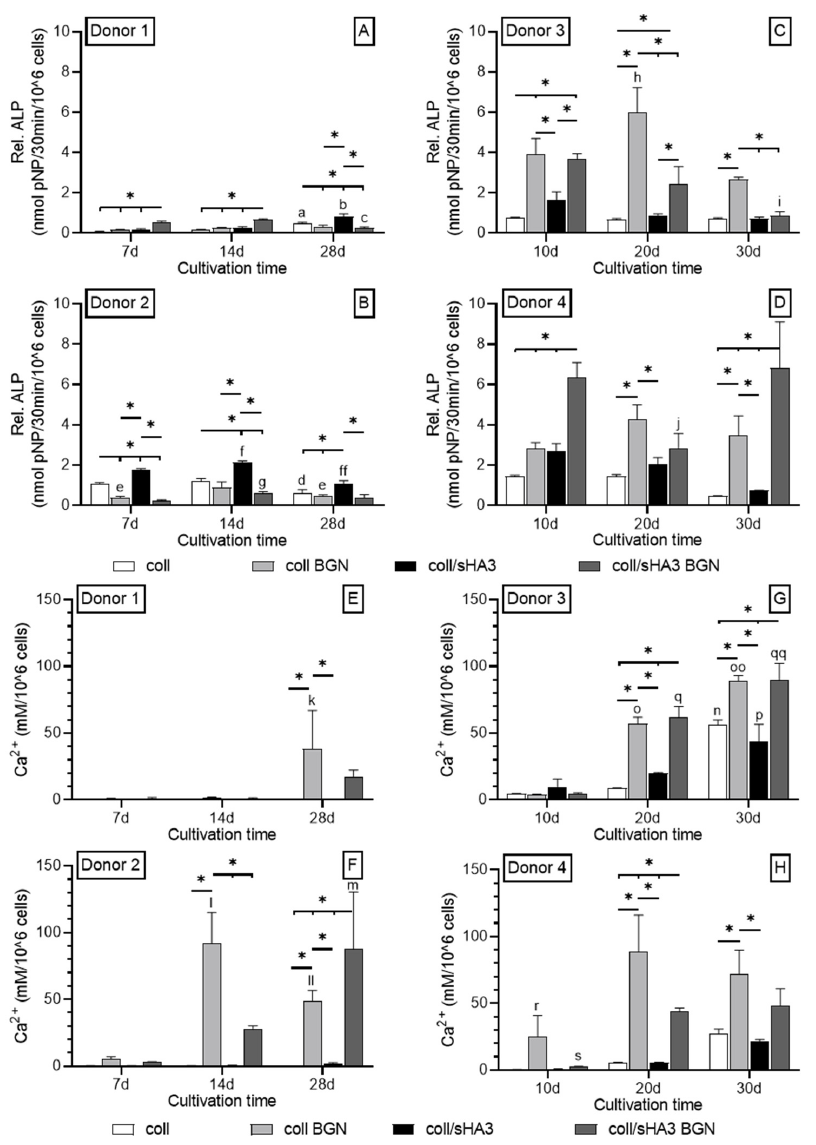
Figure 6. ALP activity and calcium deposition: Relative ALP activity ( A – D ) and calcium deposition ( E – H ) of hMSC after addition of osteogenic supplements. hMSC on aECM coatings w/o Dex (Donor